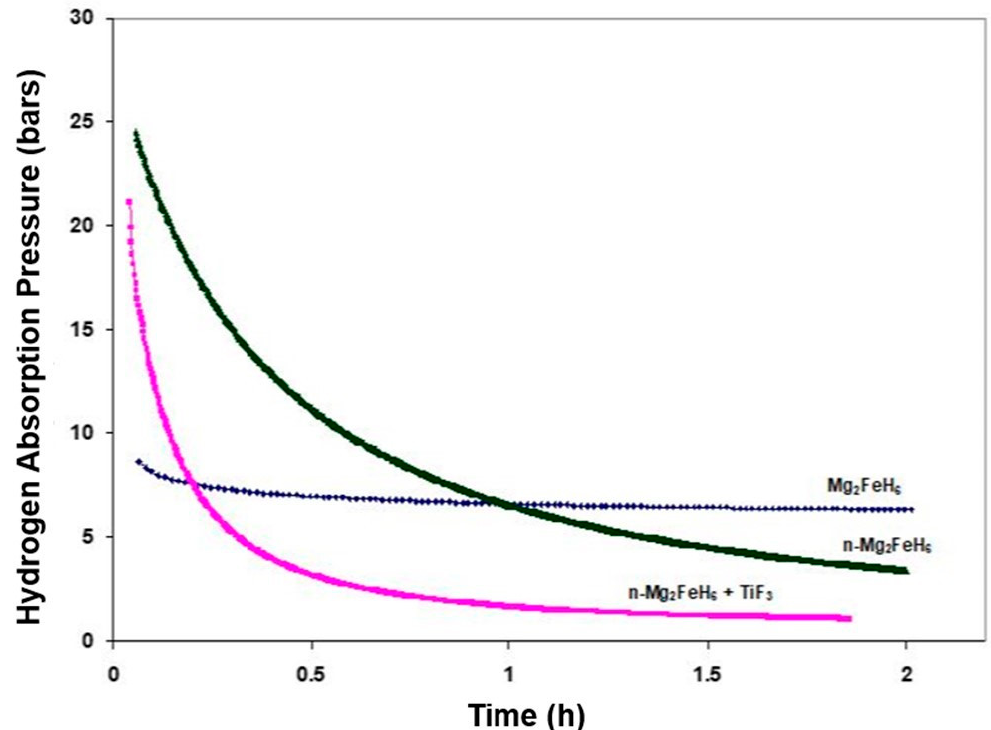
Figure 8. Hydrogen absorption kinetics of Mg 2 FeH 6 at 250 °C in its three different forms such as bulk, nanocrystalline, and 2 mol%TiF 3 nanocatalyst doped.